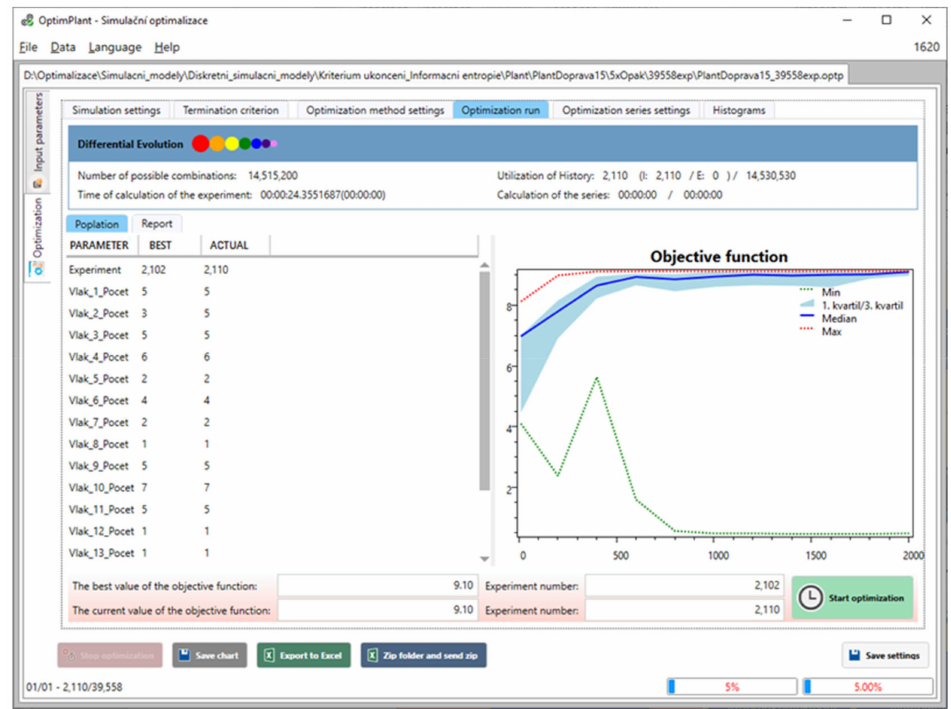
Figure 13. Simulation optimiser GUI—optimisation experiment with AGVs